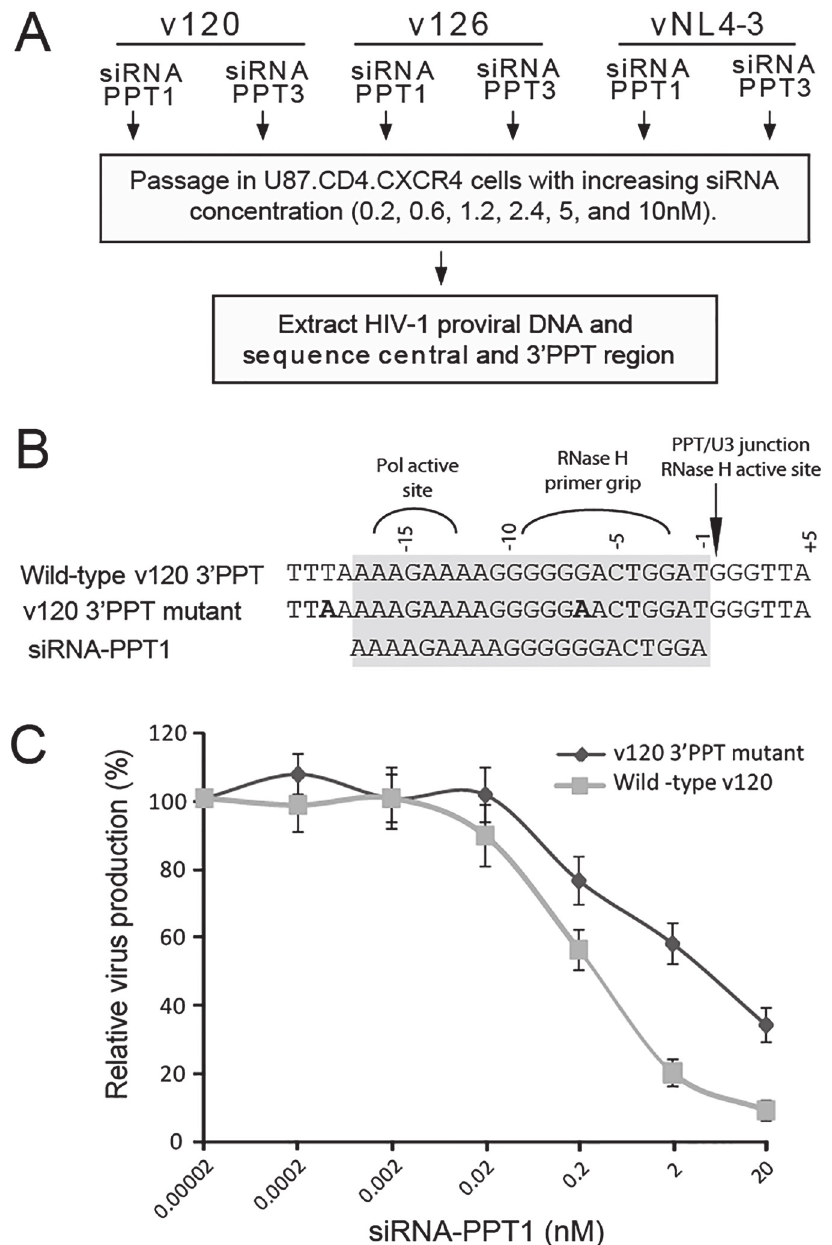
Fig 2. Generation of replication-competent PPT mutants through siRNA treatment. (A) Schematic illustrating the process of generating PPT mutants through siRNA treatment; (B) Mutated PPT in the emergent v120-A strain together with the wild-type 3 0 PPT and siRNA-PPT1 sequences; (C) Inhibitory efficiency of siRNA-PPT1 on wild-type and mutated v120-A. CD4.CXCR4 cells, while the remaining three mutants (cPPT , cPPT and T(-16)A G(-1)A/T(-16)A /3 0 PPT did not (Fig 3B). Two of the non-replicating viruses were engineered cPPT G(-1)A G(-1)A to contain a T(-16)A mutation within the cPPT, and this mutation would be expected to cause a TTT-to-TTA codon change and corresponding F185L substitution within the amino acid se- quence of integrase. F185 is located at the dimer interface of the enzyme and is critical for